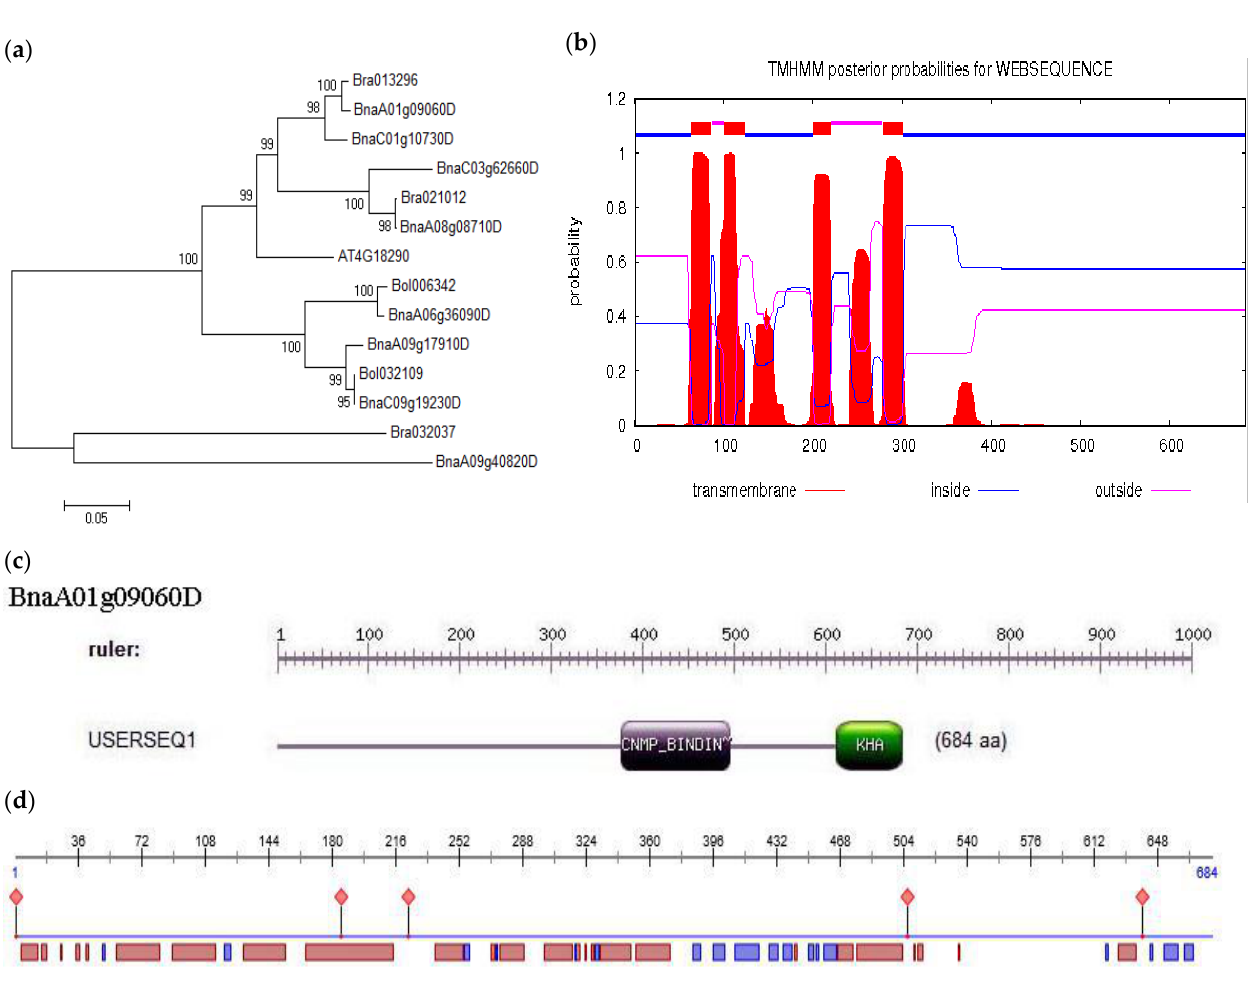
Figure 1. Bioinformatics analysis of the BnKAT2 gene. ( a ) Phylogenetic tree. ( b ) Transmembrane structure of the BnKAT2 protein. The blue line, thick red line, and pink line represent the area inside the membrane (A1 – A63; A124 – A200; A301 – A684), the transmembrane region (A64 – A86; A101 – A123; A201 – A220; A278 – A300), and the area outside the membrane (A87 – A100; A221 – A277), respectively. ( c ) Protein domains of BnKAT2 (BnaA01g09060D). ( d ) Secondary structure of the BnKAT2 protein. The red rectangle indicates the α - helix, the blue rectangle indicates the β -sheet, and the rest of the sequence is random coils; the red rhombus indicates a protein binding site.